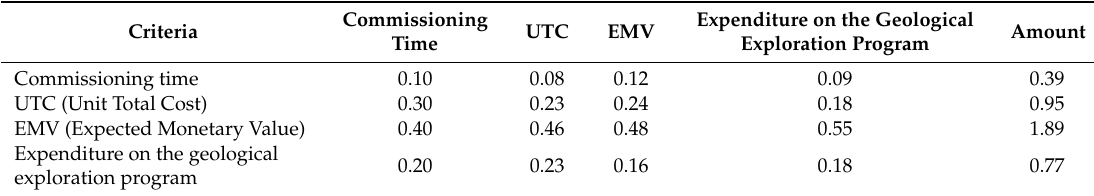
Table A7. Results of a normalized assessment of the relative importance of the investment sustainability